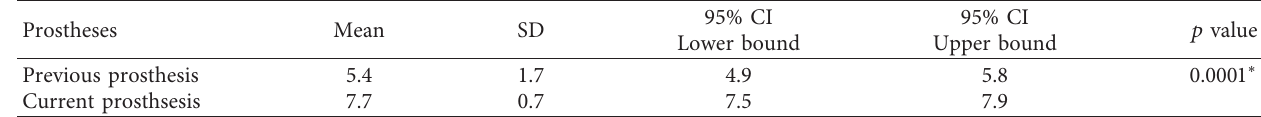
Figure 2: Participants’ overall satisfaction with previous prostheses and current basal implant.